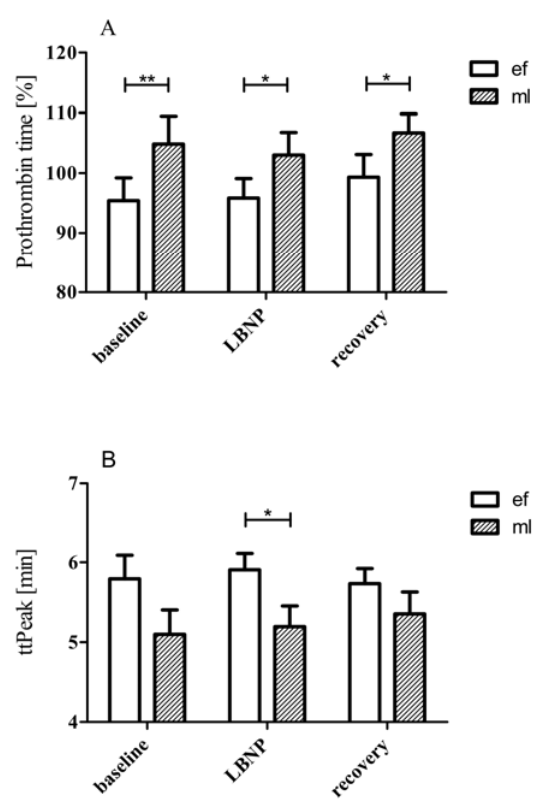
Figure 1. Prothrombin time and ttpeak values of women in early follicular and mid-luteal phases. During the ML phase, the significantly higher prothrombin time values and shorter ttpeak values (implying earlier start of thrombin generation) suggest that women in the ML phase are relatively hypercoagulable compared to those in the early follicular phase. Data are shown as mean ± SD. * ... p ≤ 0.05, ** ... p ≤ 0.01 .